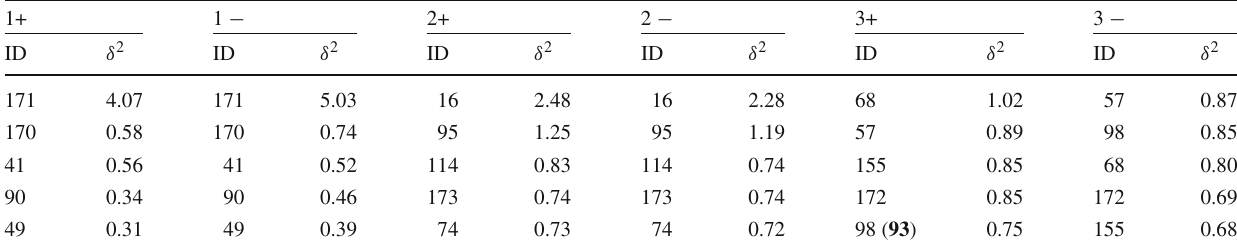
Table 4 Ranking of observables by δ along directions 1, 2, 3. In bold the changes when the SVD points are defined by the exact 1 σ surface